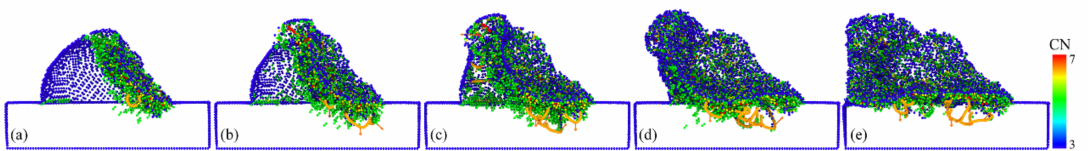
Figure 8. Plastic deformation during plowing process; ( a – e ) represents the plowing distance of d = 7 nm, 8 nm, 10 nm, 14 nm and 21